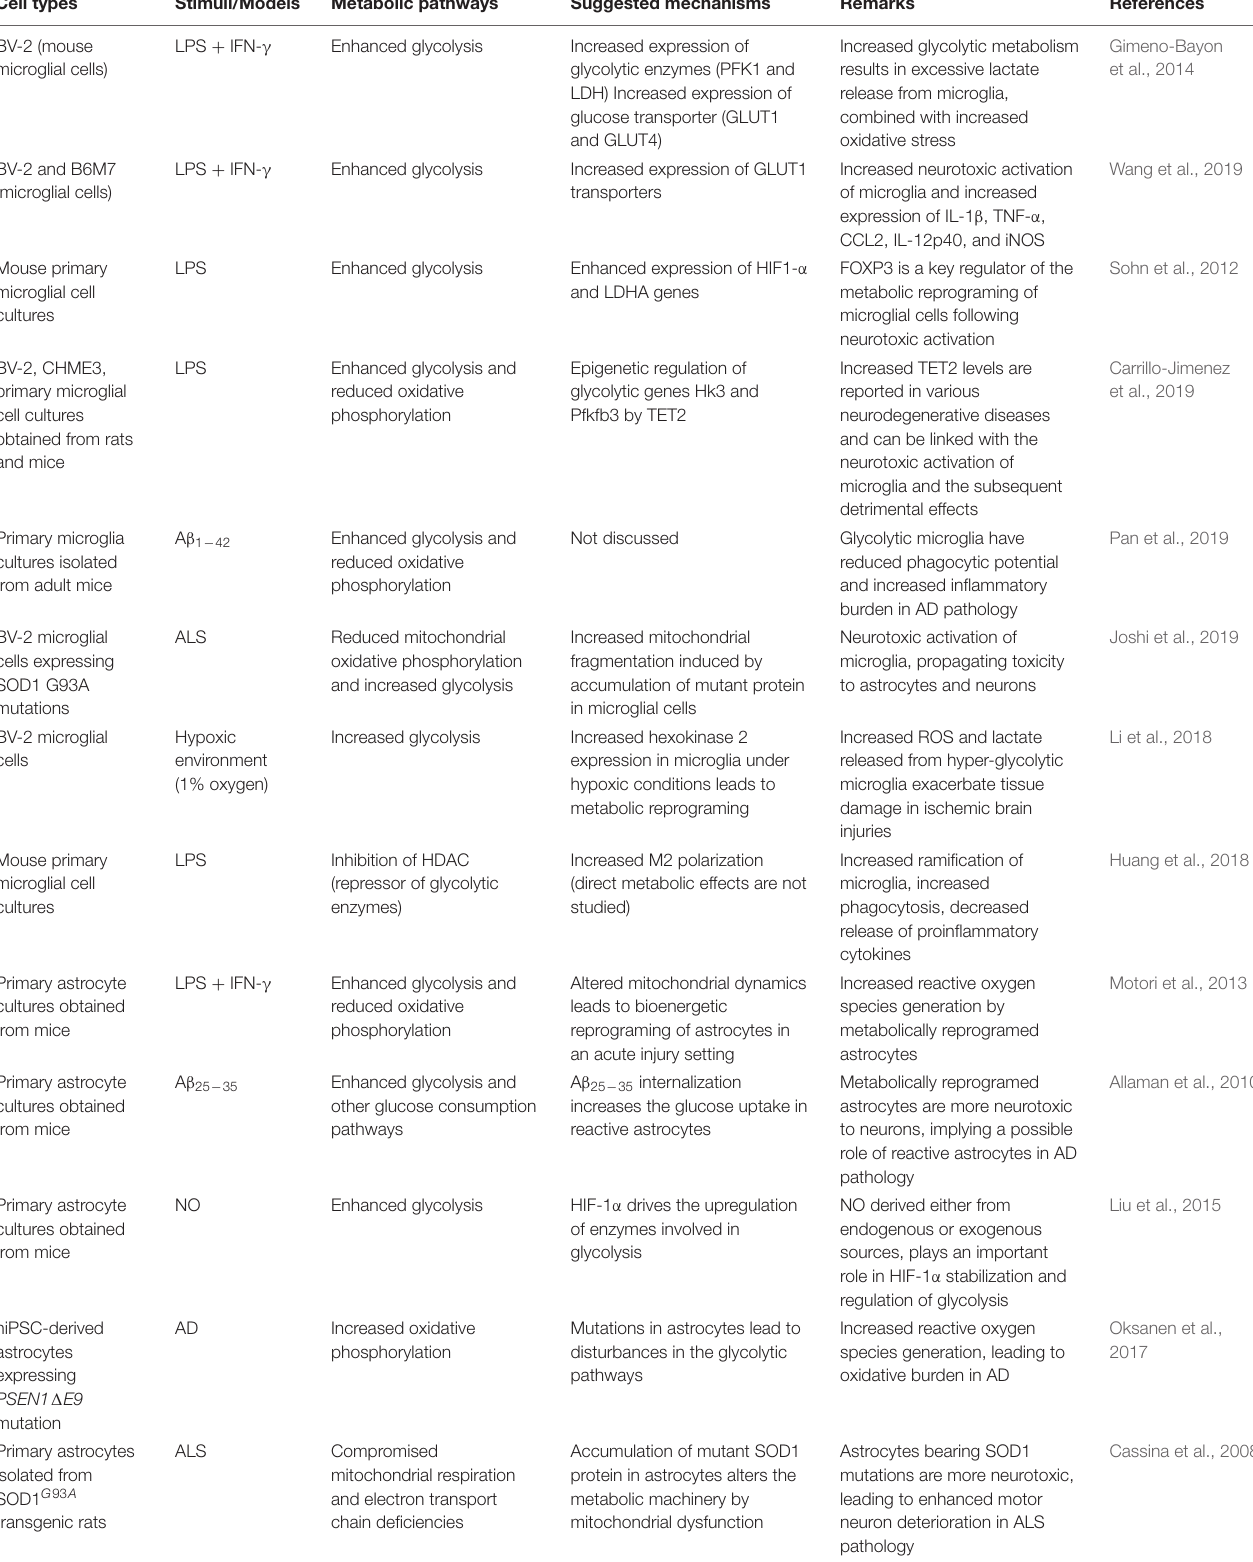
TABLE 1 | Experimental findings related to metabolic alterations of glial